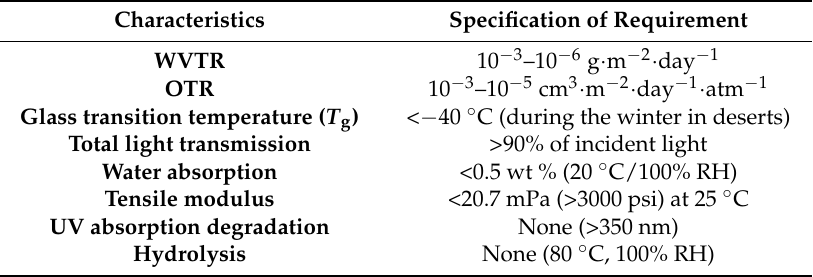
Table 1. Specifications and requirements for encapsulating materials for the protection of organic and perovskite devices from the oxygen and moisture. Reprinted with permission from [12]. Copyright 2016 John Wiley & Sons,